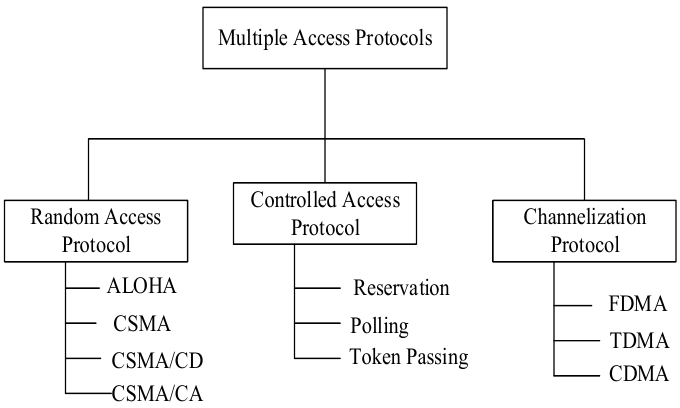
Figure 2. Taxonomy of existing medium access control (MAC) protocols for wireless local area network